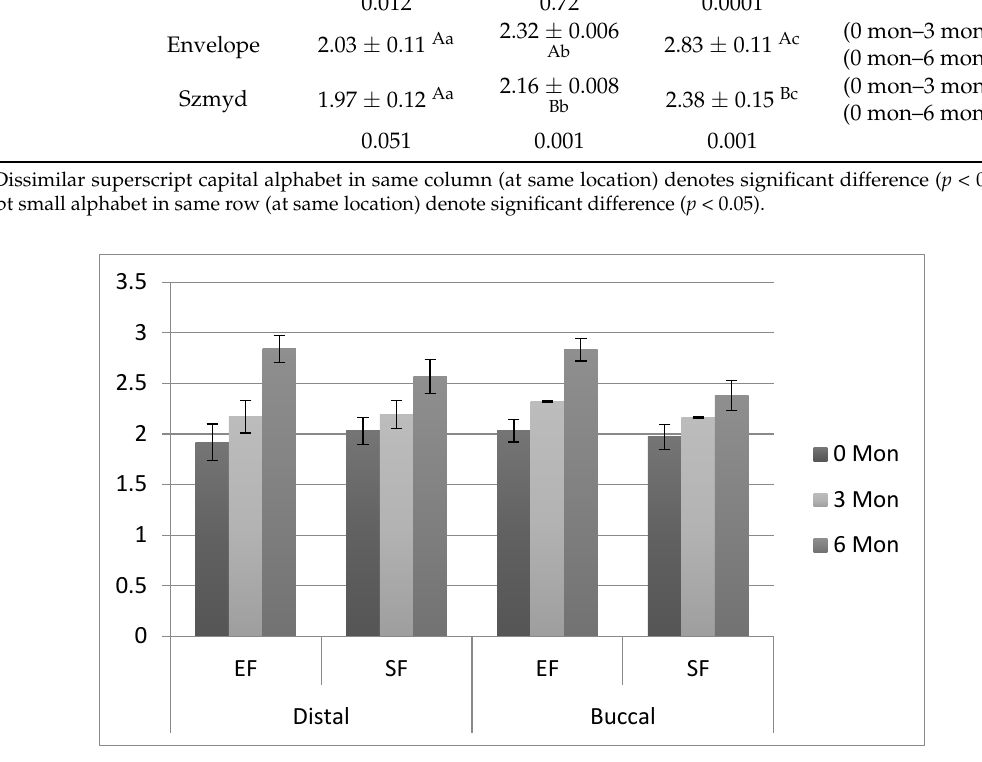
Figure 2. Comparison of means and standard deviations of periodontal pocket depths (mm) observed among the study groups. EF: Envelope flap; SF: Smzyd flap.